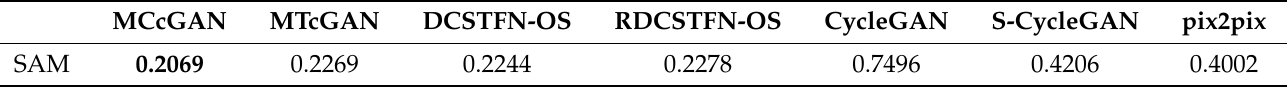
Table 6. The spectral angle mapper (SAM) of different methods in Area A at Time II (the bold result is the